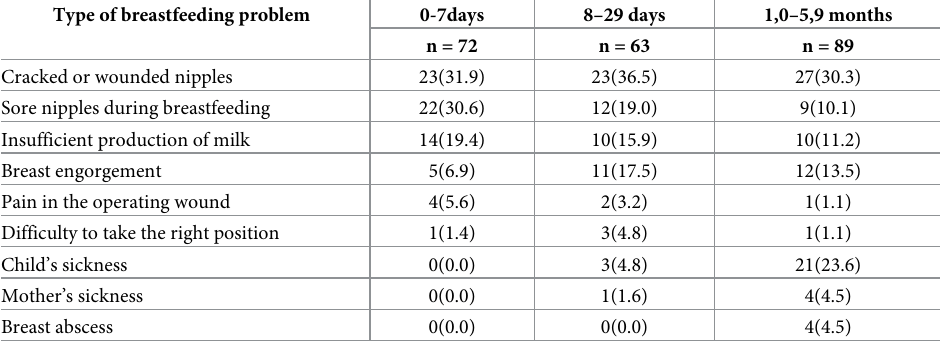
Table 3. Type of breastfeeding difficulties encountered by mothers during different periods from delivery to six